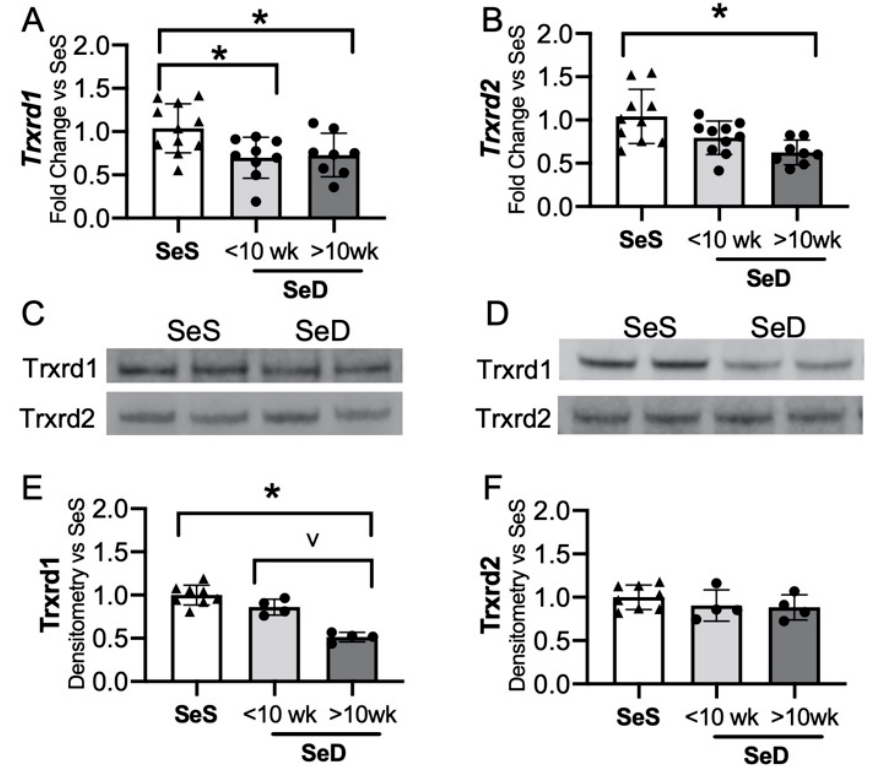
Figure 5. Neonatal hepatic thioredoxin reductase 1 is decreased by prolonged antenatal Se deficiency. C57Bl/6 mice were placed on diets that differed only in Se content, either 0.4 ppm or <0.01 ppm of sodium selenite. Breeding was initiated after 2–4 weeks on diet and natural delivery was allowed. Hepatic organ homogenate was evaluated on day of birth. Analysis is done with SeD samples separated based on if the breeding dam received more or less than 10 weeks SeD diet at time of birth. Each data point represents either a female or male from each litter; each individual point is an average of two mice. Fold change in ( A ) Trxrd1 mRNA and ( B ) Trxrd2 mRNA is shown normalized to SeS samples, ( C ) representative Western blot of hepatic Trxrd1 and Trxrd2 for SeS samples and SeD samples born to dams who received <10 weeks SeD diet, ( D ) representative Western blot of hepatic Trxrd1 and Trxrd2 for SeS samples and SeD samples born to dams who received >10 weeks SeD diet, densitometric analysis of ( E ) Trxrd1 and ( F ) Trxrd2 protein content expression. Results are normalized to total protein stain and expressed as a ratio to Se sufficient mice. N = 4–10 for all groups. Data are presented as mean (±SEM), * p < 0.05 vs. SeS control by mul- tiple comparisons after one-way ANOVA, ∨ p < 0.05 vs. SeD <10 weeks by multiple comparisons after one-way ANOVA.